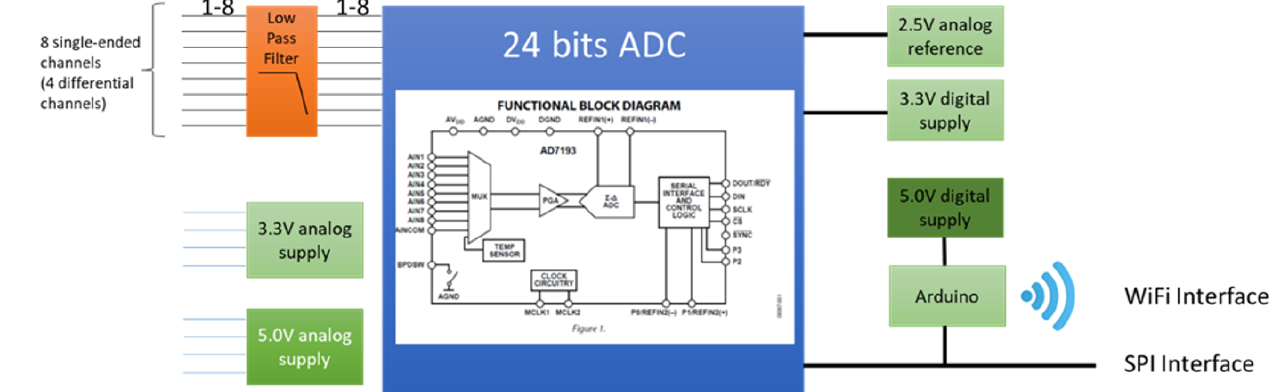
Figure 3. Block diagram of the magnetoresistive sensor